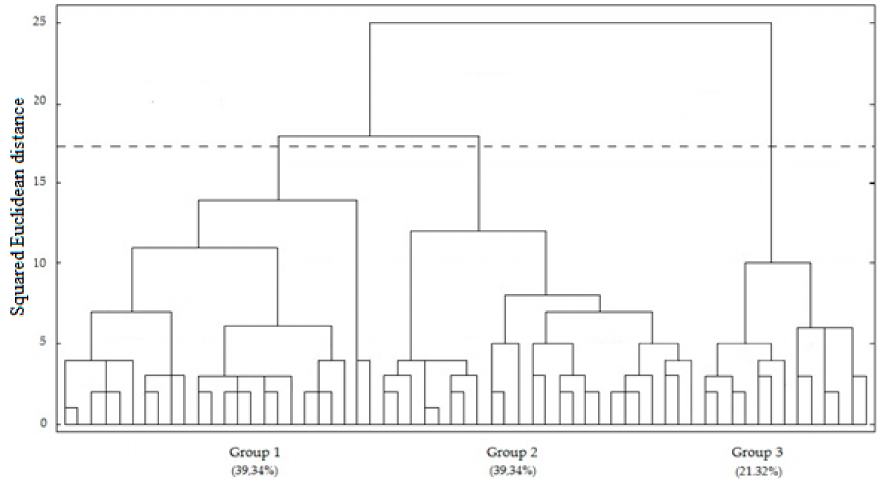
Figure 4. Dendrogram using a Ward linkage to establish three groups within the Kichwa communities in sector A (Pompeii, Indillama, Santa Elena, and Itaya) in the northern Yasun í Biosphere Reserve (YBR) of the Ecuadorian Amazon (percentage of chakras in each group). Table 4. Means and standard deviation of sustainability indicators among clusters (groups) of the chakra systems in sector A in the north of the Yasun í Biosphere Reserve in the Ecuadorian Amazon